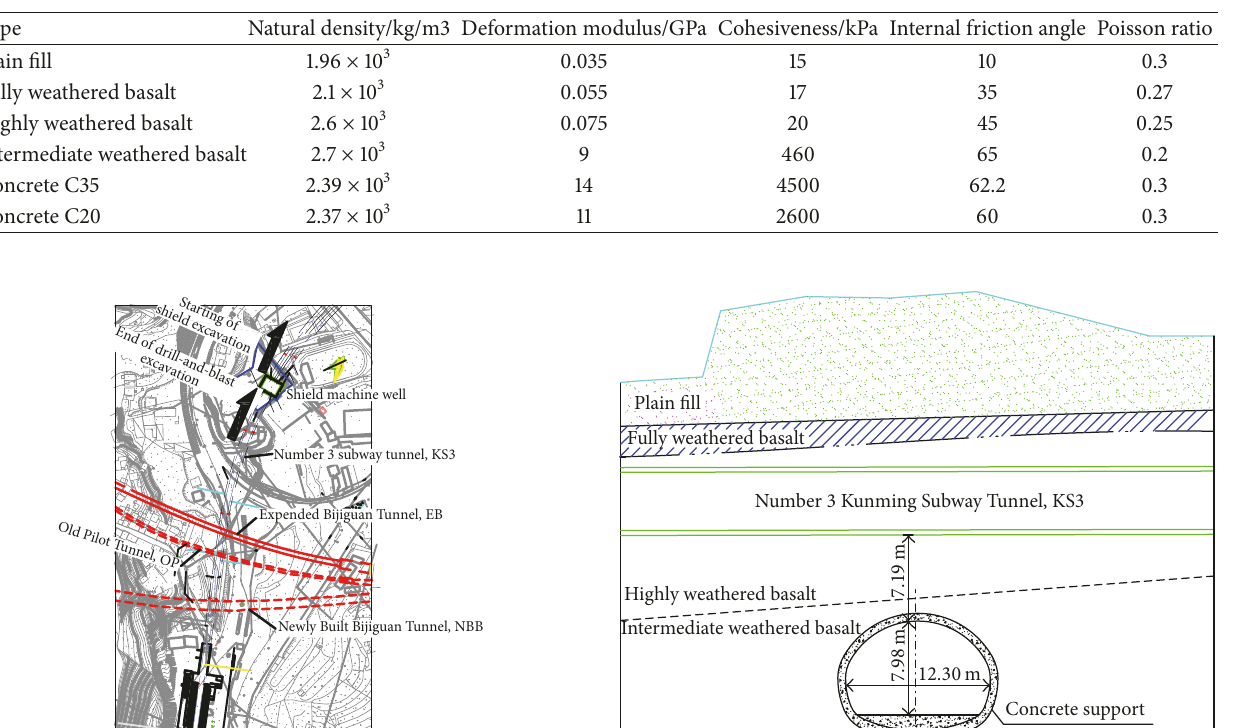
Table 1: Material parameters.